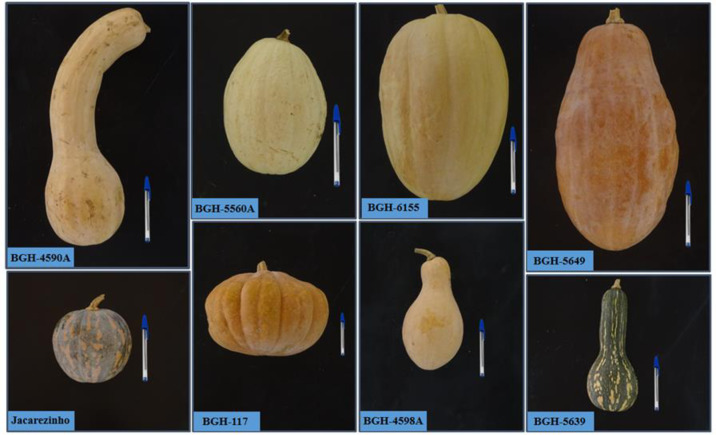
Figure showing the morphological pattern of fruits representative of part of the groups obtained with genotypes clustering.BGH-4590A (group 3), BGH-5560A and BGH-6155 (group 11), BGH-5649A (group 12), Jacarezinho and BGH-117 (group 1), BGH-4598A and BGH-5639 (group 14), BGH-5548A (group 2), BGH-5453A and BGH-5544A (group 5), and BGH-900 (group 13).